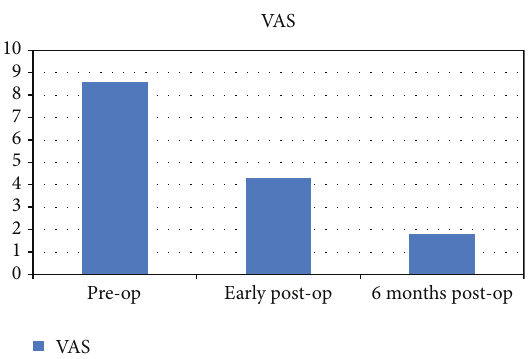
Figure 4: Comparative chart of mean VAS from preoperative period, early postoperative, and at 6-month follow up.